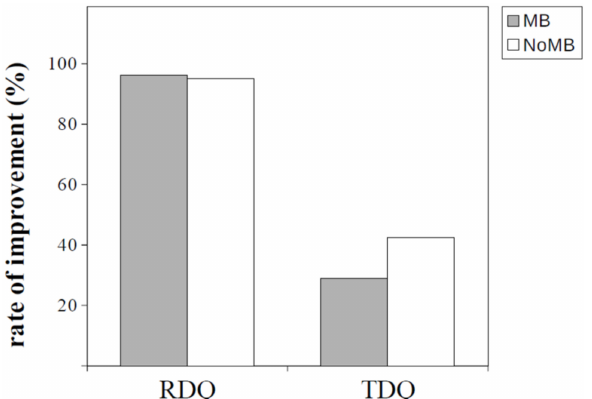
Figure 3. Bar chart illustrating the rate of improvement in the RDQ and TDQ scores in the MB and NoMB groups. MB, mucosal break; NoMB, no mucosal break; RDQ, reflux disease